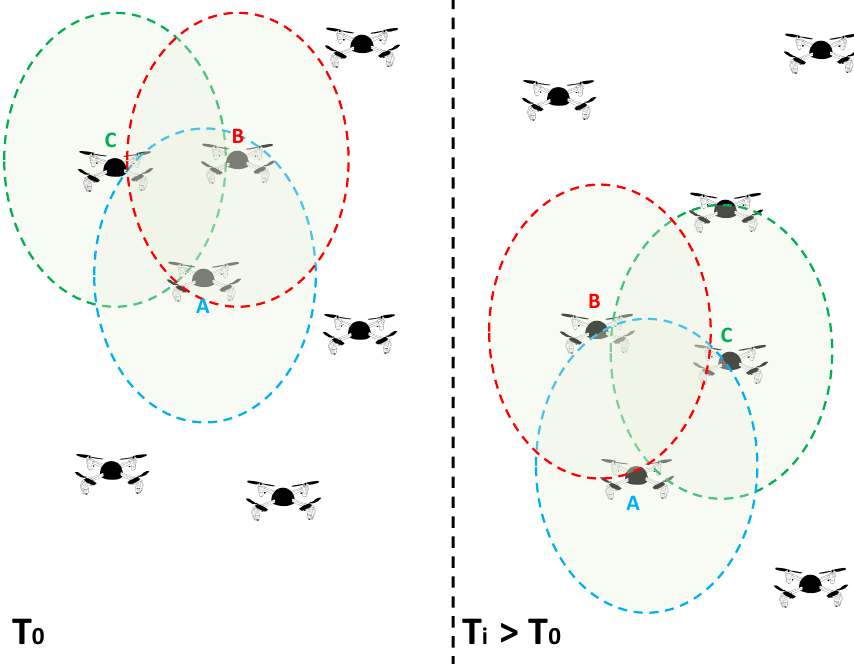
Figure 3. UAVs trusting each other and moving with similar mobility